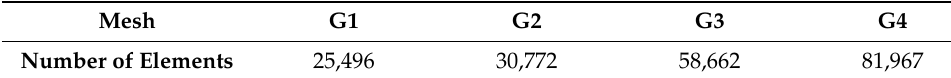
Table 2. Numerical test results for grid independency study.